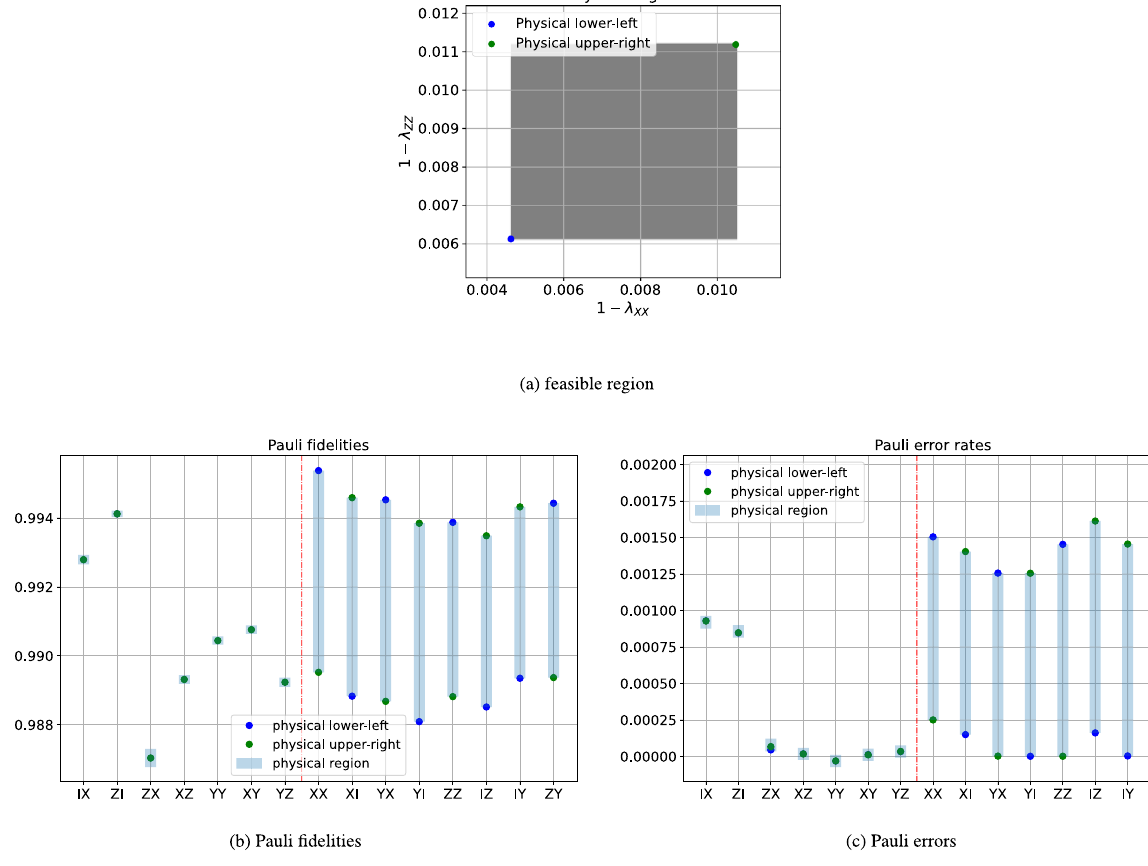
Fig.4|FeasibleregionofthelearnedPaulinoisemodel,usingdatafromFig.3. a Feasible region of the unlearnable degrees of freedom in terms of λ XX and λ ZZ .